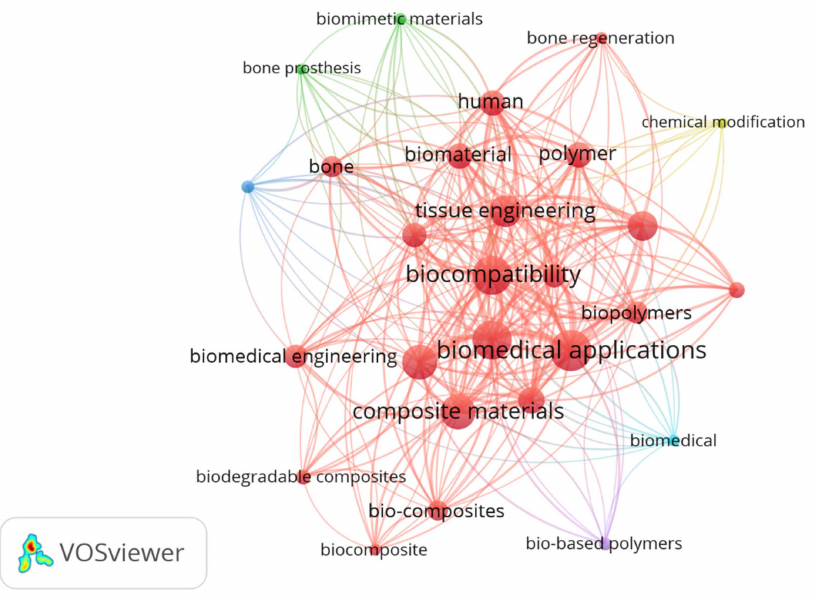
Figure 11. Bibliometric assessment on the applications of natural fiber/synthetic fiber reinforced thermosetting polymeric composites for biomedical and human prosthetic